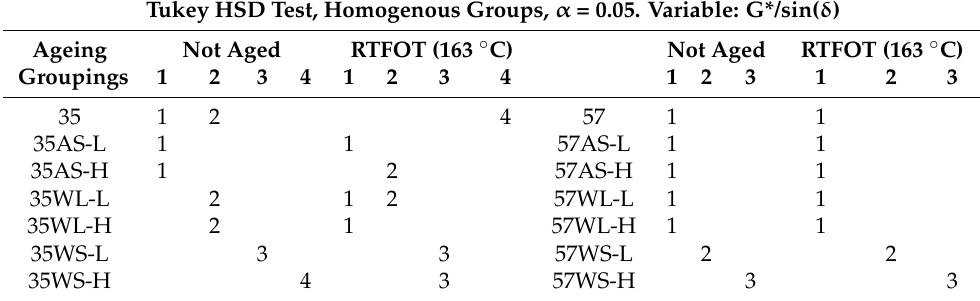
Table 6. Results of Tukey HSD tests for distinguishing homogenous groups (G*/sin( δ ), α = 0.05) within the tested bituminous binders.